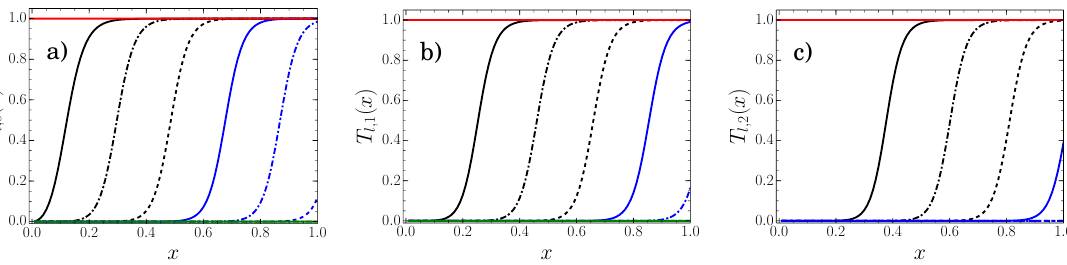
Figure 2. Regge–Wheeler for Schwarzschild: Greybody factors . Plots of the transmission probabilities, T (cid:96) , s ( x ) , as a function of x = M ω for, ( a ) scalars, ( b ) photons, and ( c ) gravitons. The leftmost function on each plot corresponds to the (cid:96) = s transmission probability, increasing (cid:96) values occur to the right. These greybody factors (for the Regge–Wheeler potential in Schwarzschild spacetime) exhibit very strong similarities and relatively minor differences. The greybody factors almost seem to be translations of one another, and all appear to be similar to suitably shifted hyperbolic tangent functions. See Figure 3. We shall discuss the implications of this observation more fully in the subsequent section on “modeling”.